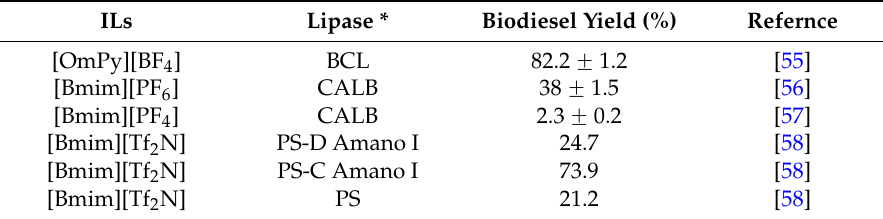
Table 1. Comparisons of biodiesel yield catalyzed by lipase in ionic liquids (ILs). ILs Lipase * Biodiesel Yield (%)